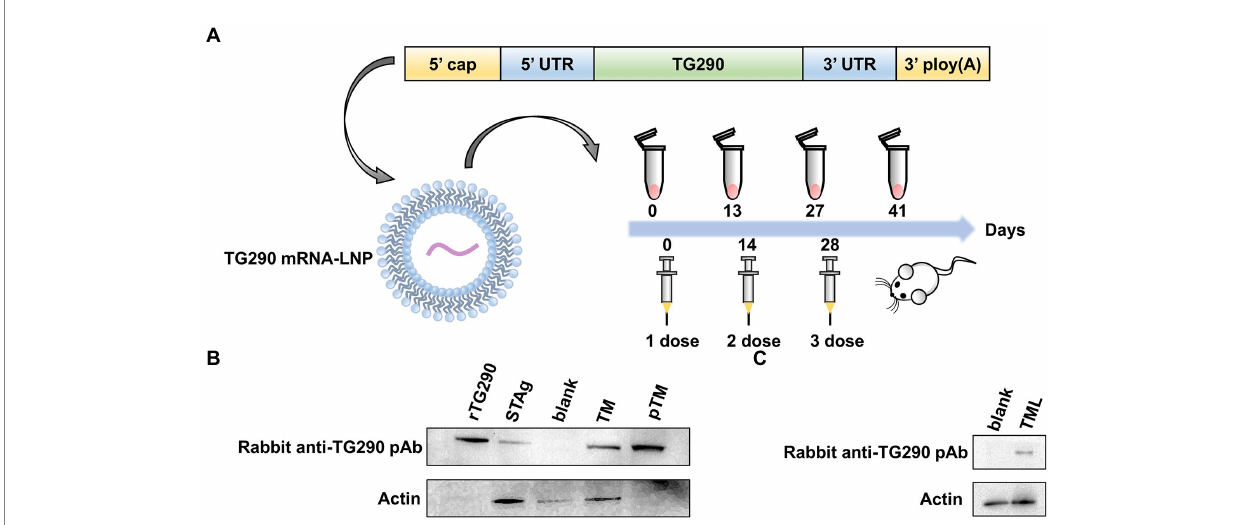
FIGURE 2 The construction, protein expression and delivery of TG290 mRNA-LNP vaccine. (A) The engineered mRNA construct. An mRNA encoding the TG290 was designed with 5 ′ and 3 ′ untranslated regions (UTRs) flanking the coding sequence, a 5 ′ cap-1 structure and a 3 ′ poly(A) tail. In vitro -synthesized mRNA encapsulated in a lipid nanoparticle to be applied in in vitro and in vivo experiments. (B) The expression of TG290 in HEK293 cell lysates and STAg was determined by Western blot. rTG290 served as a positive control; STAg: (soluble antigen of T. gondii ); Blank: non-transfected cells; Unpurified cell lysate from TG290 mRNA-transfected cells ©; Purified supernatant from TG290 mRNA-transfected cells (pTM). (C) In vitro -synthesized TG290 mRNA was encapsulated in a lipid nanoparticle and administered to C2C12 cells. Lysate was analyzed by Western blotting with Rabbit anti- TG290 pAb. Blank: empty transfected cells; TG290 mRNA-LNP transfected cells (TML).